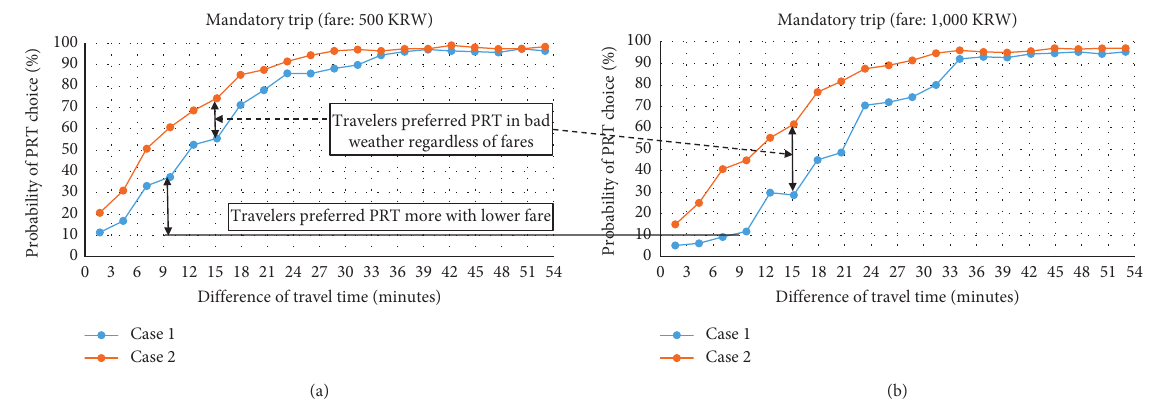
Figure 6: Impacts by weather and fare on PRT choice in the mandatory trip.